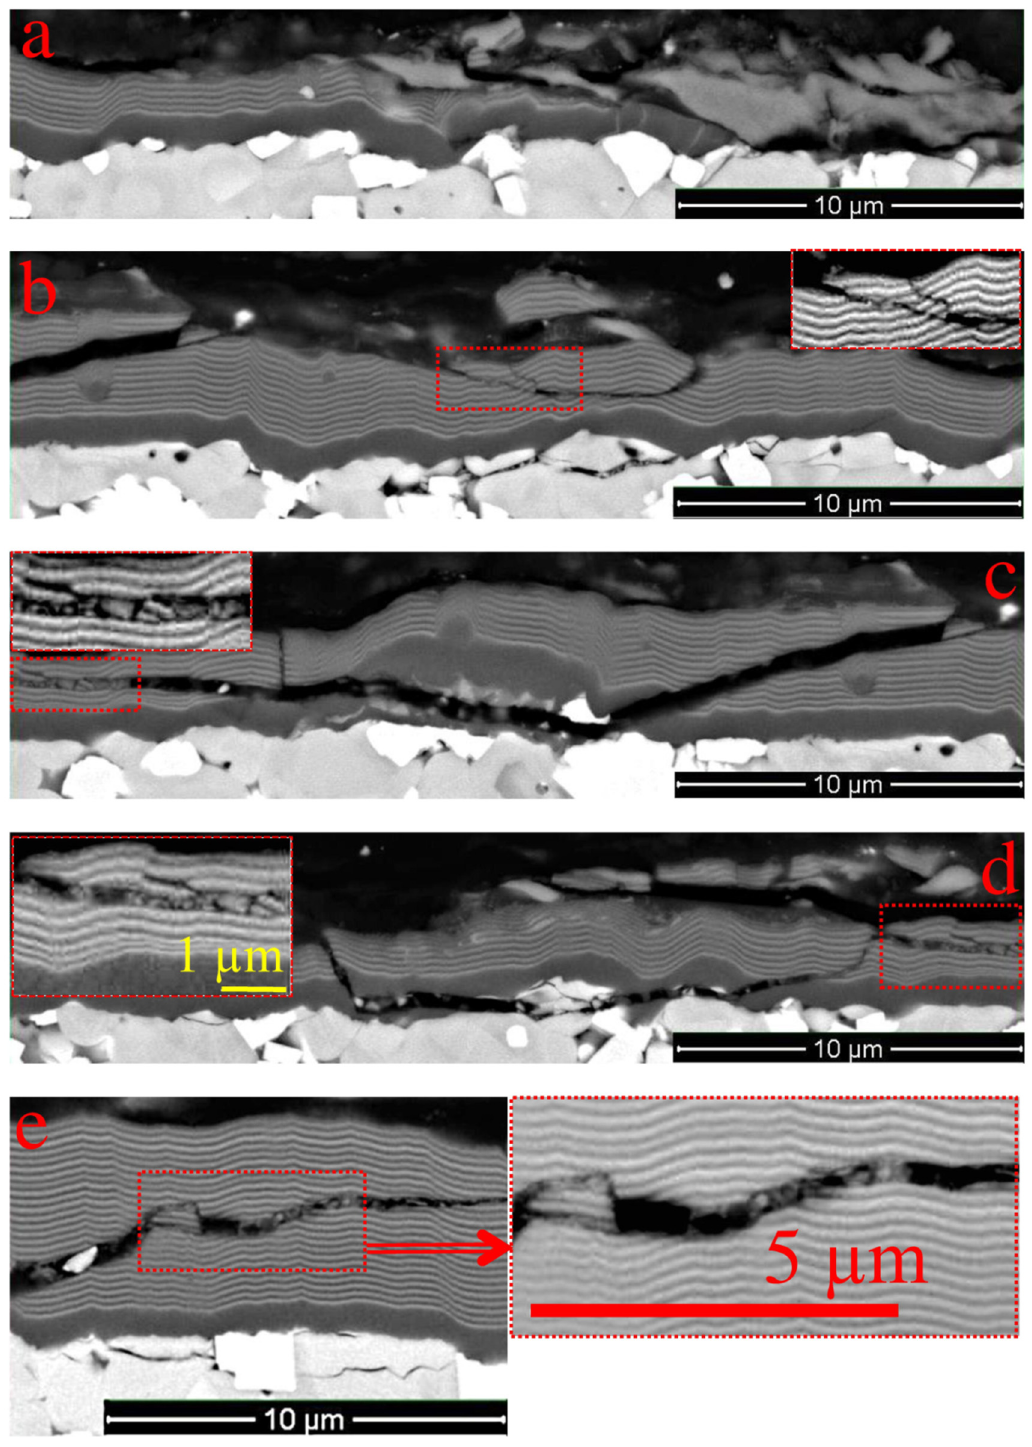
Figure 9. Fracture pattern for coating Ti-TiN-(Ti,Cr,Mo,Al)N on the rake face of the carbide tool (SEM), ( a ) the nature of destruction of the coating at the boundary of the crater of wear, ( b – e ) the nature of cracking in the structure of the coating.